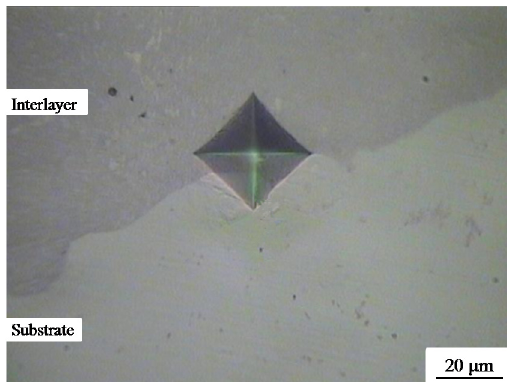
Figure 7. Interfacial indentation at a load of 500 g.